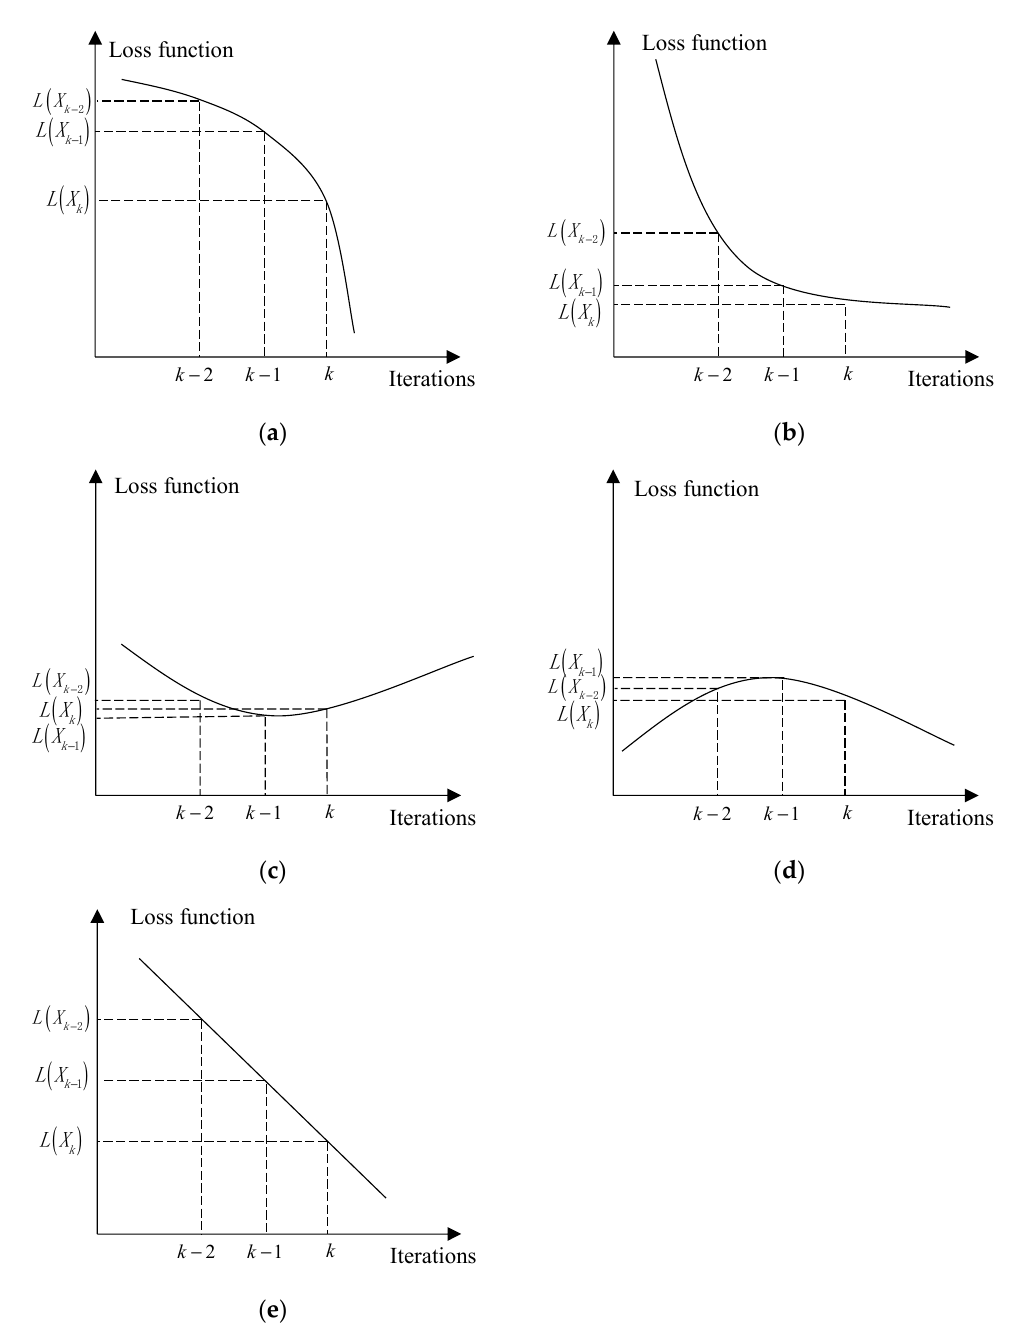
Figure 8. Diagram of typical local optimization scenes: ( a ) Local rapid descent scenario; ( b ) local slow descent scenario; ( c ) local concave oscillation scenario; ( d ) local convex oscillation scenario; ( e ) local uniform descent scenario.